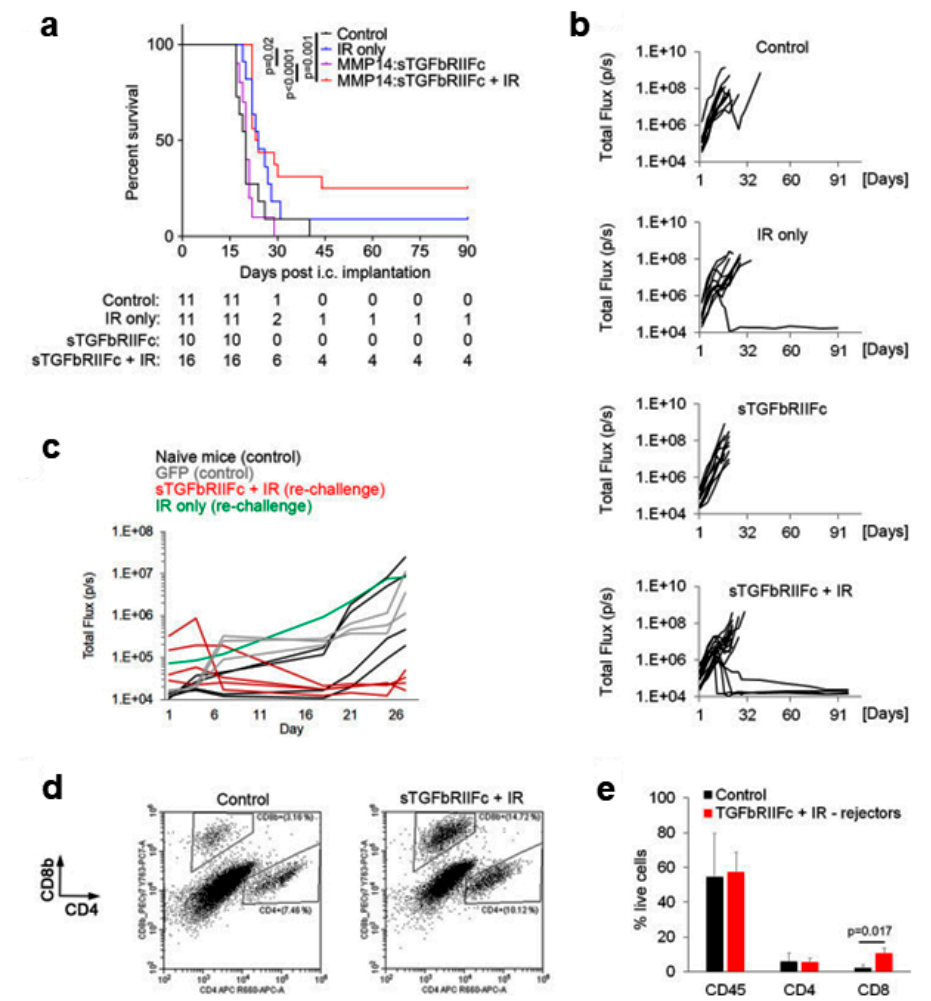
Figure 2. Hematopoietic stem cell (HSC) gene therapy targeting transforming growth factor beta (TGF β ) in combination with IR results in a long-term protection against intracranial GB. ( a ) Survival of mice bearing GL261 intracranial tumors. The table below the graph shows group sizes at the beginning (day 0) and number of animals at risk (e.g., animals that are alive) for indicated days. Pooled data from two independent experiments are shown. Statistical significance was determined by a two-tailed log-rank test. ( b ) Growth curves for individual tumors as obtained by bioluminescence imaging, displaying total flux in photons per second (p/s). ( c ) Mice that rejected GL261 tumors following the first intracranial implantation of cancer cells plus therapy were rechallenged by a second intracranial implantation of GL261 cells at 90 days post-tumor rejection (red and green lines). Mice that have received transplantation of MMP14: GFP-transduced HSCs (gray lines) or naïve mice (black lines) were implanted with GL261 cells intracranially for the first time and used as controls. Tumor growth was quantified by bioluminescence imaging as in ( b ). ( d , e ) Representative dot plots showing analysis of CD8+ and CD4+ T cells ( d ) and quantification of immune cells ( e ) in intracranial tumors (control mice as specified in c ) or brain area corresponding to the cancer cell implantation site (mice that have rejected tumors for the second time in the combination therapy group) by flow cytometry at 3 weeks post-cancer cell implantation. Statistical significance was determined by two-tailed t -test (n = 3 and 4, respectively, in first and second experiment for control group; n = 2 per experiment for rechallenged long-term survivors from the combination therapy group) (modified after [68] with permission).